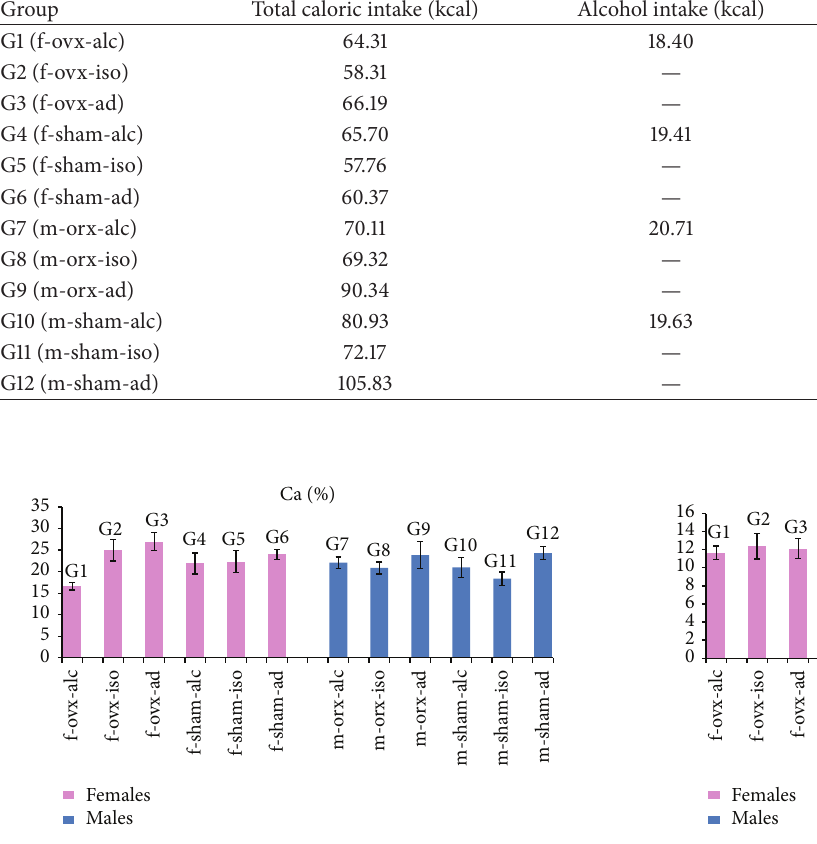
Figure 3: P (%): the graph illustrates the values of the averages (bars) and standard deviations (lines superimposing the